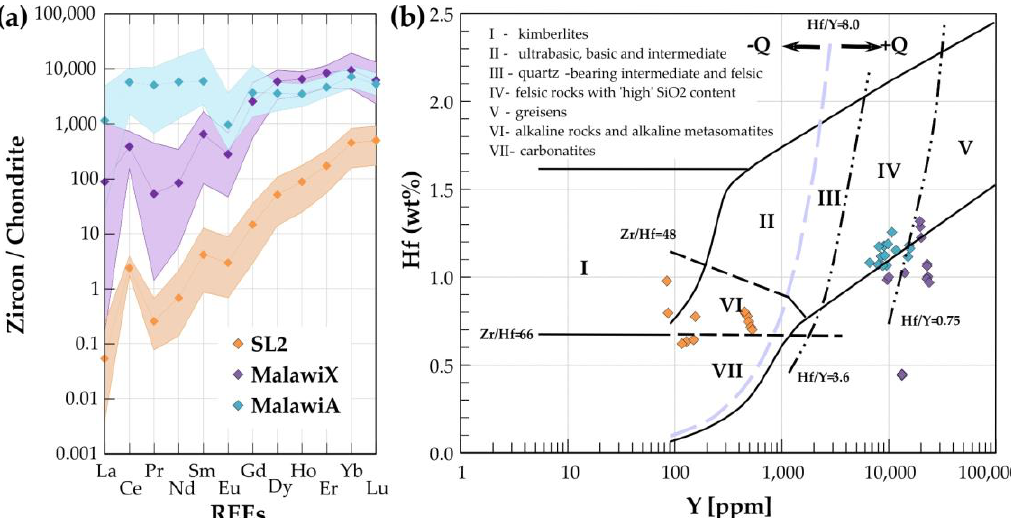
Figure 8. Results of LA-ICP-MS trace-element analyses of zircon samples from Sri Lanka (SL2) and Mt. Malosa pegmatites, Malawi obtained from their annealed crystal halves. Detailed results are given in Tables A7–A9. ( a ) Plots of mean chondrite-normalised REE concentrations of sample SL2 ( n = 13), MalawiX ( n = 14), and MalawiA ( n = 14) with their limits given colour-shaded, respectively. ( b ) Zircon provenance discrimination diagram after Shnukov [77] using Hf and Y concentrations. Expected fields of source rock type are indicated (details see [65]).